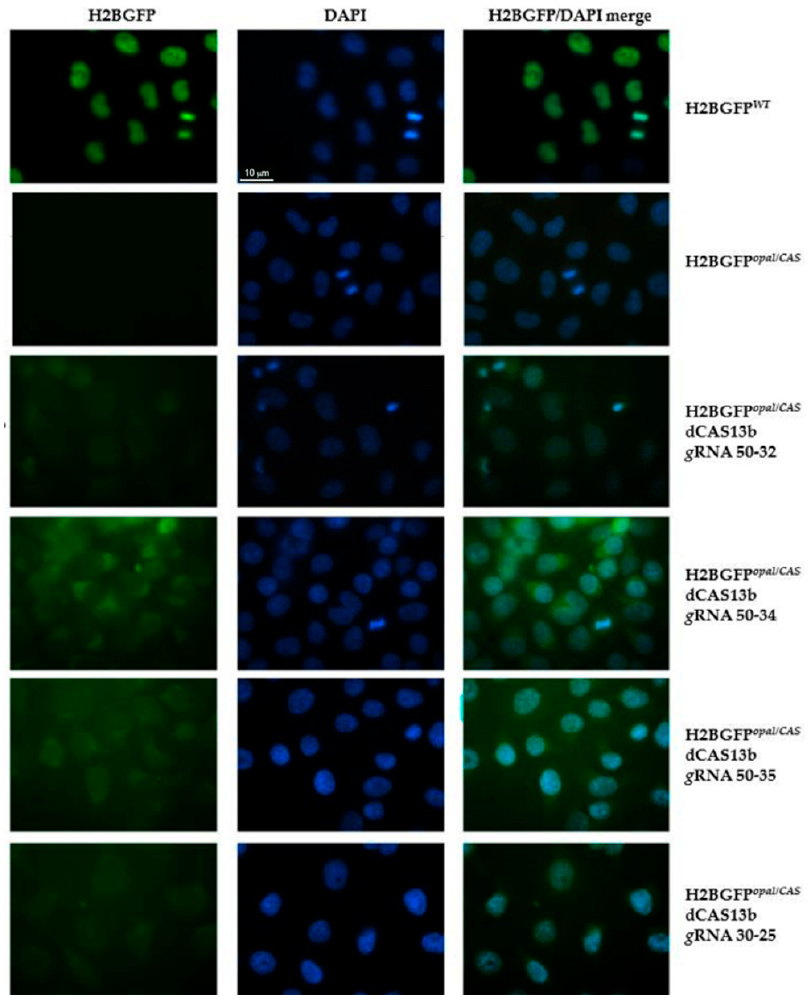
Figure 3. Fluorescence analysis after editing the PTC (UGA) in HeLa-H2BGFP opal cells stably expressing dCAS13b/ADAR2 DD . HeLa cells stably expressing dCAS13b/ADAR2 DD were transfected with selected g RNAs coding plasmids (300 ng of total DNA). Two days after transfection, cells were fixed with methanol for 5 min and the H2BGFP (green) was detected using the 63x objective on a ZEISS microscope equipped for epifluorescence. Nuclei were stained with DAPI (blue). HeLa-H2BGFP WT cells and untransfected HeLa-H2BGFP opal cells, expressing dCAS13b/ADAR2 DD , were used as positive and negative control, respectively.